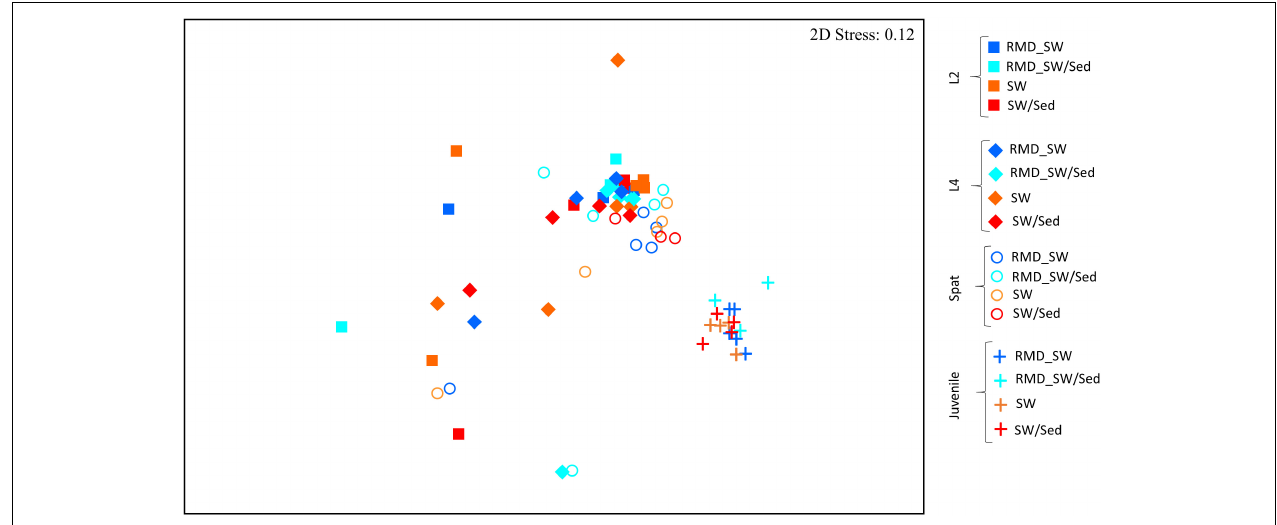
FIGURE 5 | Non-metric multidimensional scaling (nMDS) of entire microbial communities associated with Acropora digitifera early life stages and reared among different environmental conditions. Development stages are indicated as: L2, 2-day-old larvae (squares); L4, 4-day-old larvae (diamonds); Spat, newly settled spat (circles); Juvenile, 6-month-old juveniles (cross). While the colors indicated the rearing environment: RMD_SW, reduced microbial cell density seawater (blue); RMD_SW/Sed, reduced microbial cell density seawater and sediment (light blue); SW, seawater (orange); SW/Sed, seawater and sediment